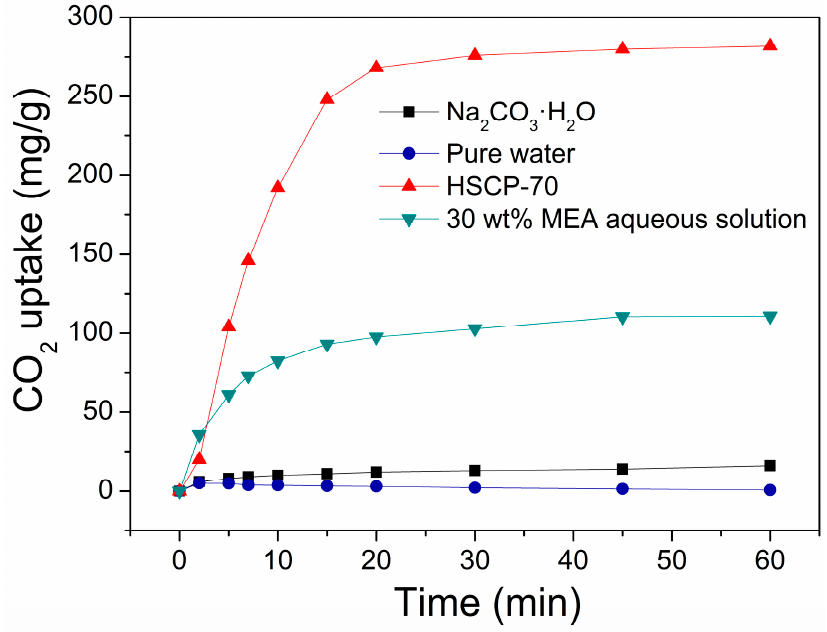
Figure 4. CO 2 sorption kinetics of HSCP-70, pure water, 30 wt % MEA aqueous solution, and Na 2 CO 3 ·H 2 O at 30 °C.